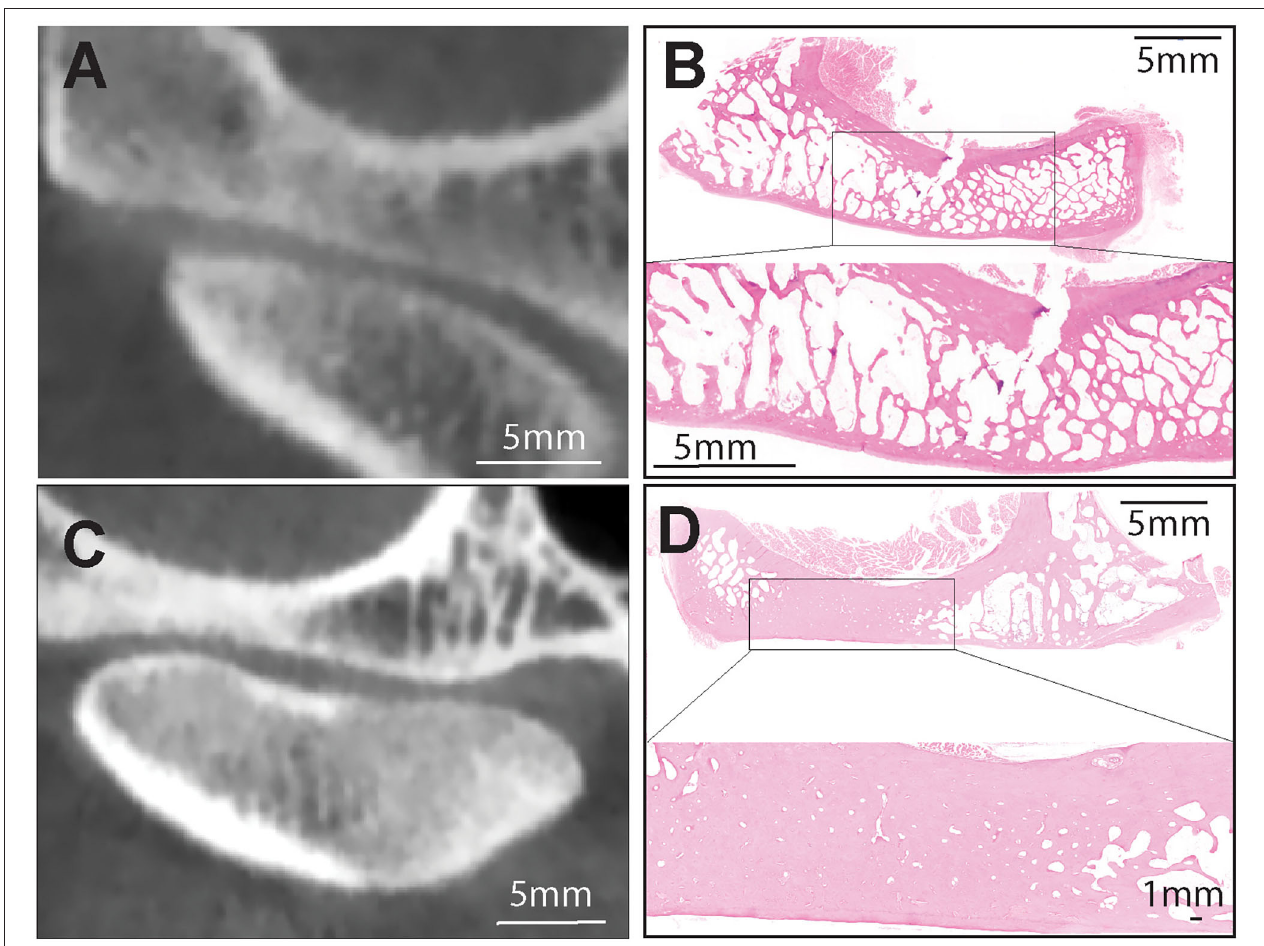
FIGURE 1 | (A,B) Representative transverse CBCT and histology images of a dog demonstrating normal, non-sclerotic bone of mandibular fossa and condylar process. (C) Representative transverse CBCT image of a dog demonstrating joint space narrowing and subchondral bone sclerosis at the mandibular fossa which correlated with excellent agreement with histologic evidence of sclerosis (D) . H&E staining of the mandibular fossa depicted in (C) . Note extensive area of bone sclerosis characterized by reduction of marrow cavities as compared to other areas in the mandibular fossa. Bar = 1mm and closeup Bar = 5mm.